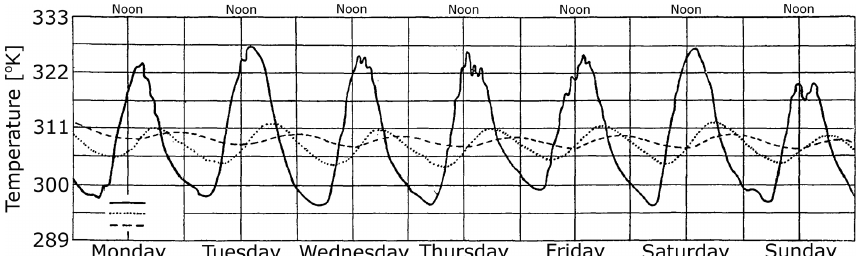
Fig. 3. Continuous measurements of soil temperatures over 7 days by CSIRO, Australia, in January (Summer) 1939 (acc. to West